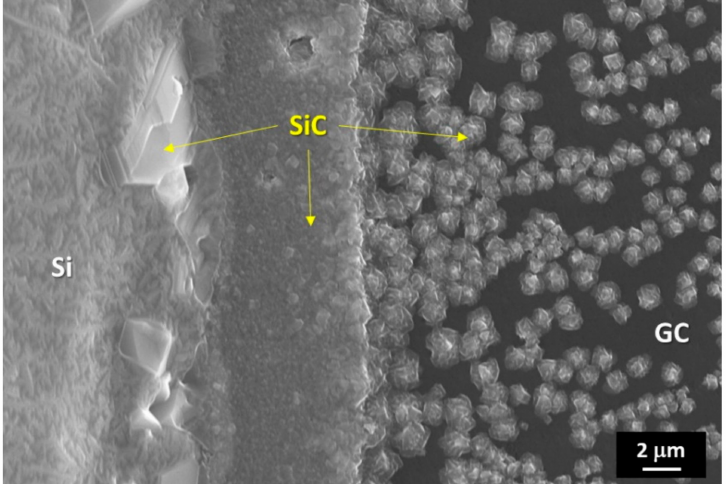
Figure 3. SEM image and proposed phase identification by EDS analysis that was performed on the Si / GC couple at the triple line-top drop and after the wetting test performed at T = 1450 ◦ C under a static Ar atmosphere for 15